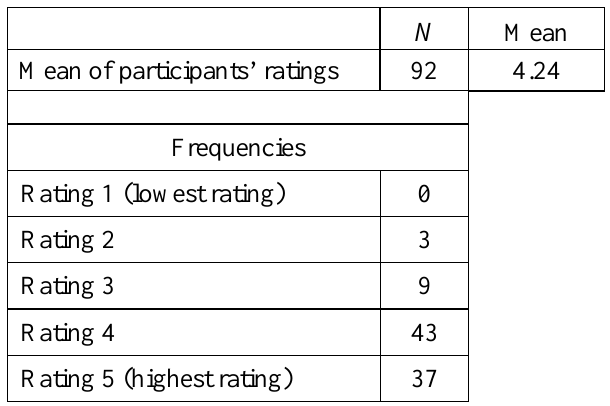
Table 5 Mean and Frequencies of Ratings of Overall Experience with